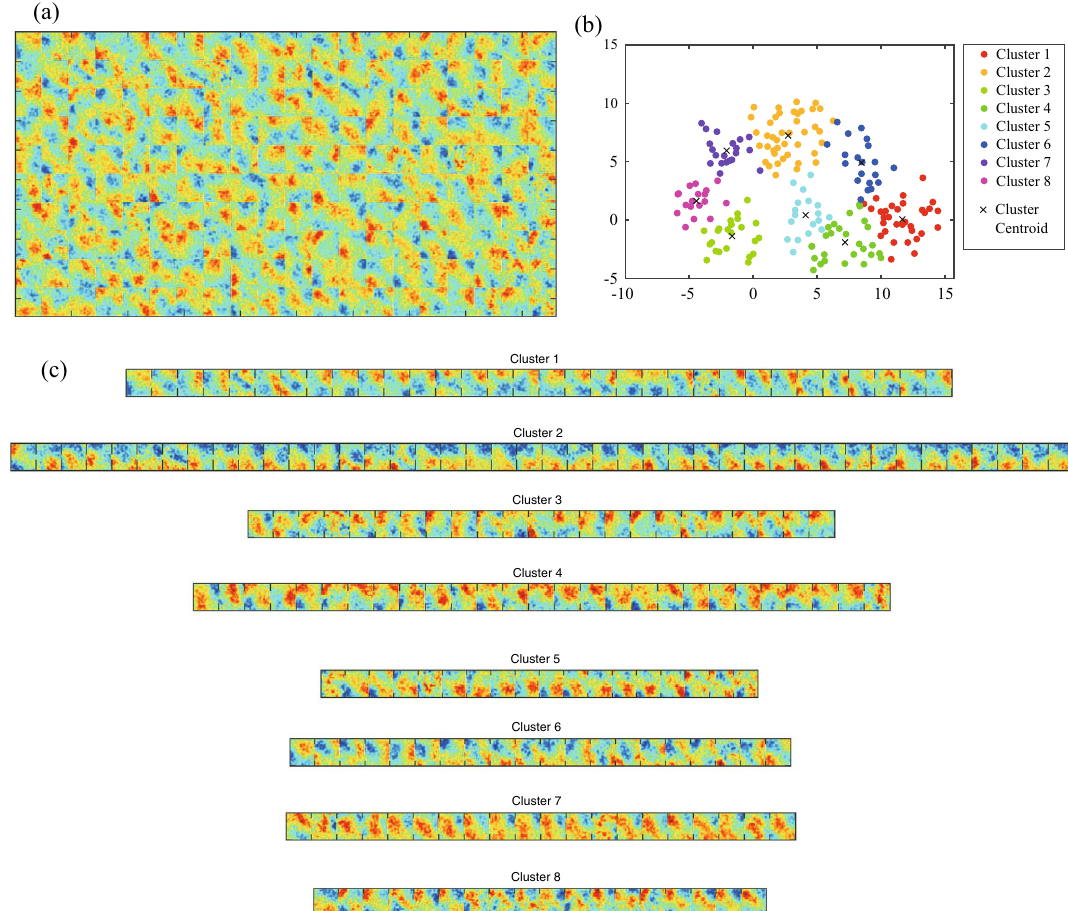
Figure 5. Dictionary trained by using rock CT images. ( a ) Basis images obtained by dictionary learning. ( b , c ) Clustering and visualization of basis images in the dictionary obtained from the rock CT images. In subfigures, ( b ) clustering results, and ( c ) basis images for each cluster are shown. In subfigure ( b ), each multi-dimensional vector for respective basis image is mapped into two-dimensional space by the dimension reduction method called t